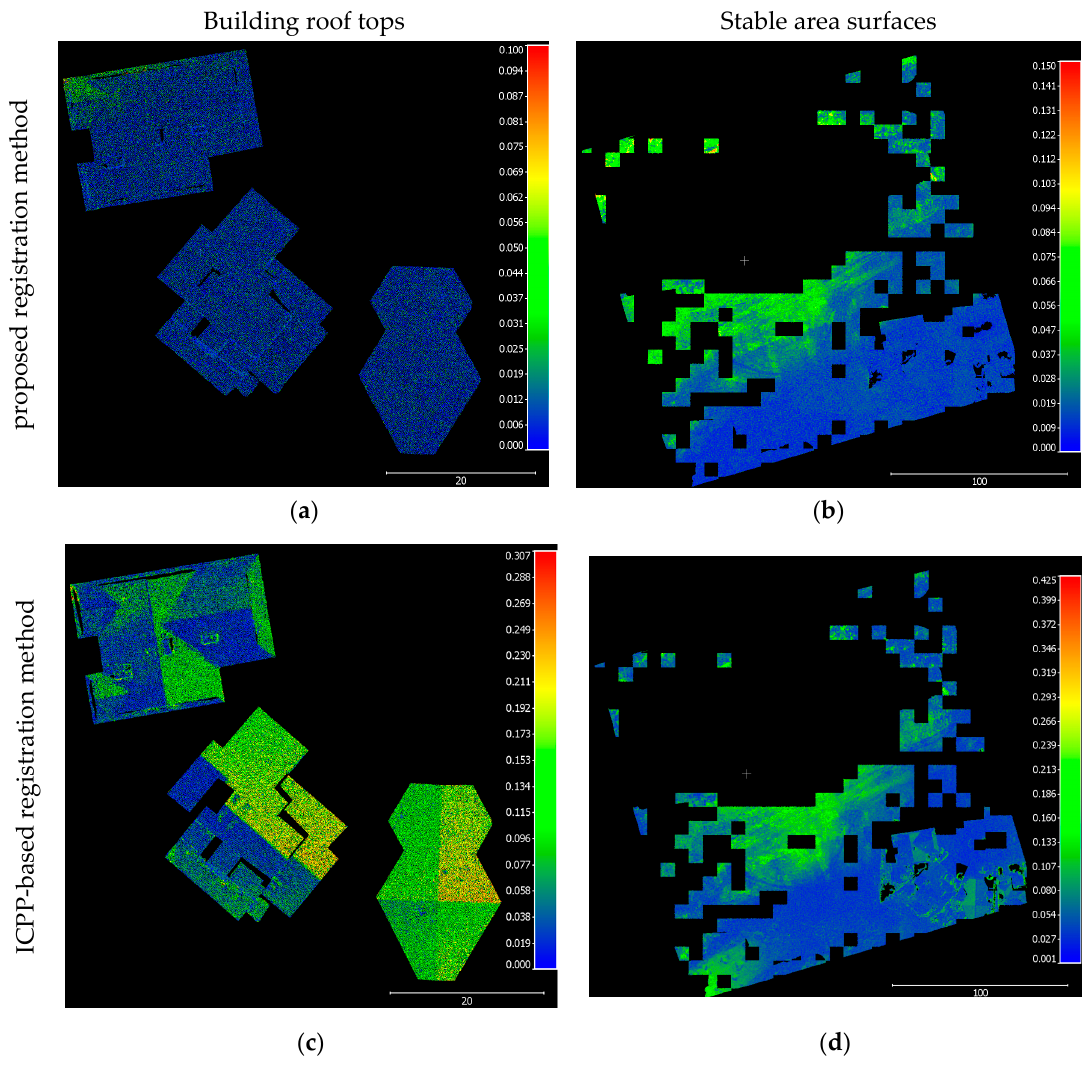
Figure 11. The top views of the two registered 3D dense image-based point clouds over the span of one year utilizing selected patches from the Lethbridge, Alberta, datasets to estimate quantitative quality control. The colours represent the normal distances calculated using the different methods. ( a ) Proposed registration method using the building roof tops point cloud; ( b ) Proposed registration method using the stable area surfaces point cloud; ( c ) ICPP-based registration method using the building roof tops point cloud; and ( d ) ICPP-based registration method using the stable area surfaces point cloud.